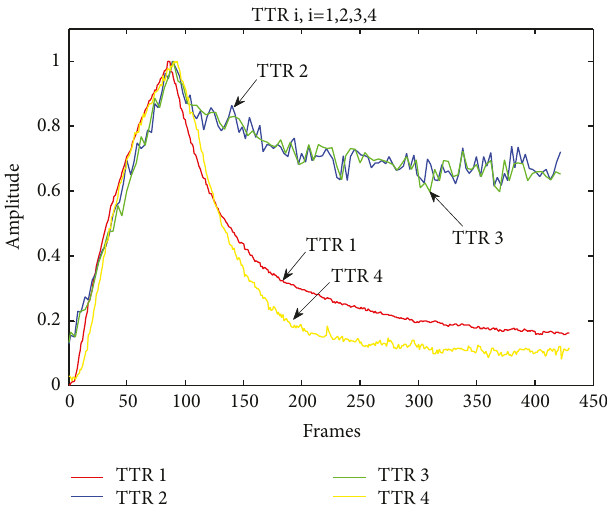
Figure 19: The comparison of 𝑇𝑇𝑅 1 , 𝑇𝑇𝑅 2 , 𝑇𝑇𝑅 3 , and 𝑇𝑇𝑅 4 of sample